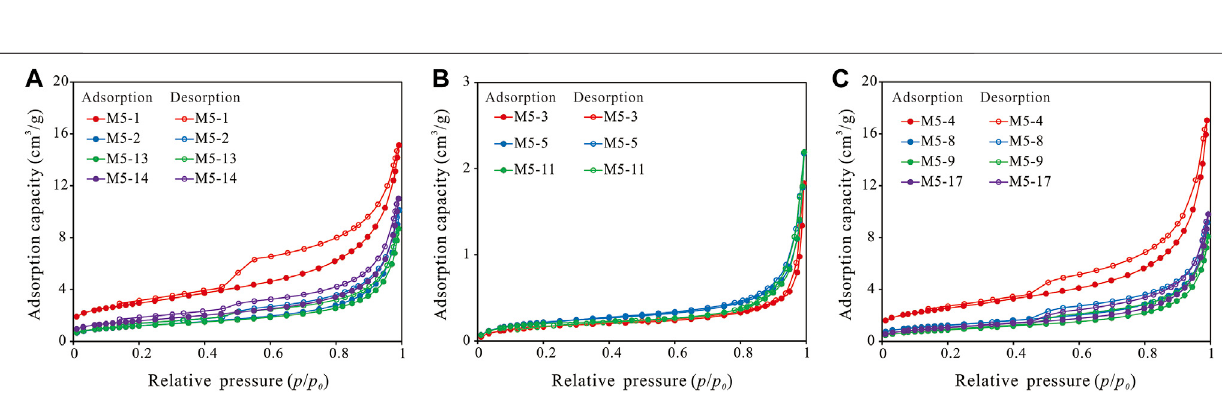
FIGURE5| Typicalmercury intrusion poresizedistributioncurves forsampleswithdifferentlithologiesthatcollectedfrom theShan2Member. (A) Shale; (B) Coal; (C) Tight sandstone.